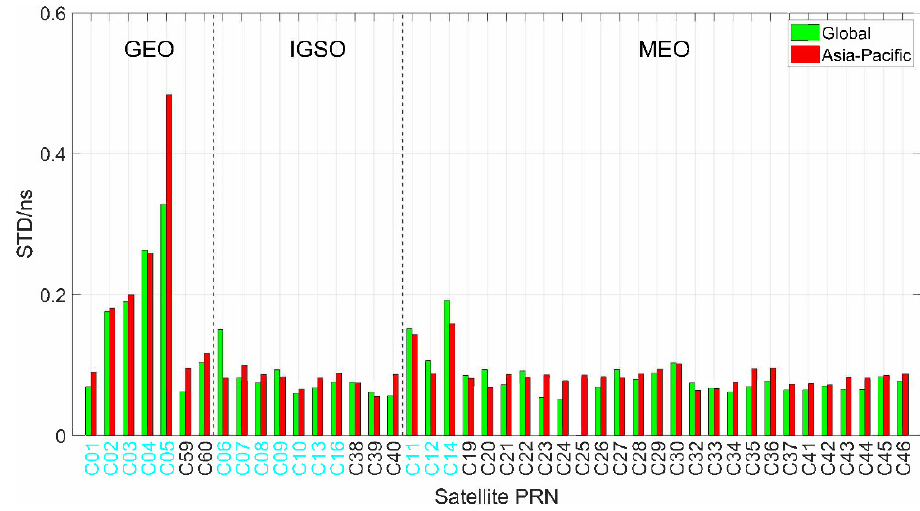
Figure 4. Global/Asia-Pacific mean precision of BDS clock offset in DOY 214–243.